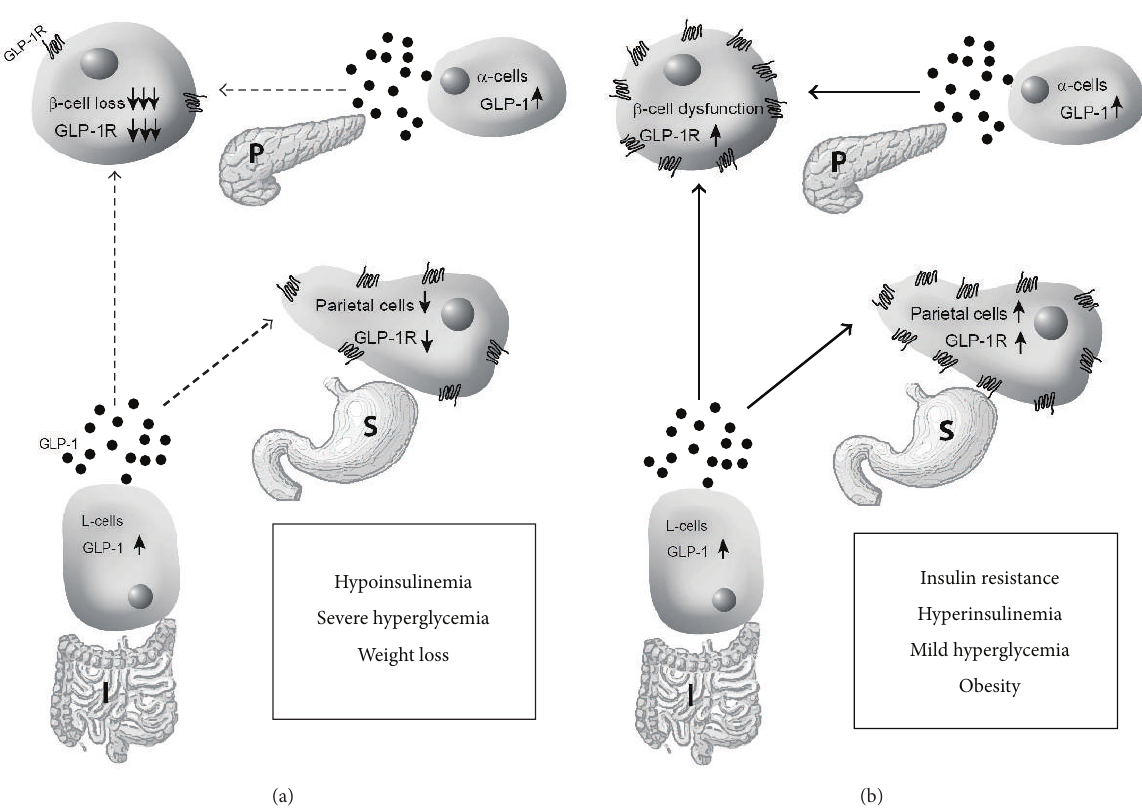
Figure 5: A schematic model displaying the opposite alterations of GLP-1/GLP-1R system in enteropancreatic axis in T1DM and T2DM experimental diabetes. (a) In STZ-induced T1DM, GLP-1 secretion from intestinal L cells and pancreatic alpha cells is increased (upward thin arrows). However, STZ toxicity causes severe loss of pancreatic beta cells and mild loss of extrapancreatic gastric glands parietal cells with the resulting decrease of the GLP-1 receptor (downward thin arrows). The discrepancy between increased GLP-1 secretion and reduced GLP-1R expression results in severely impaired GLP-1/GLP-1R signaling in pancreas and to a lesser degree in the stomach (broken thin and thick arrows). (b) HE diet-induced T2DM is characterized by increased GLP-1R on beta cells in pancreas and gastric parietal cells which are also increased in number as well as increased GLP-1 secretion from pancreatic alpha cells and extrapancreatic intestinal L cells (upward thin arrows). The joint increase in GLP-1 secretion and GLP-1R expression in enteropancreatic axis results in upregulation of endocrine and paracrine GLP-1/GLP-1R signaling in pancreas and stomach (thick arrows). P: pancreas; S: stomach; I: